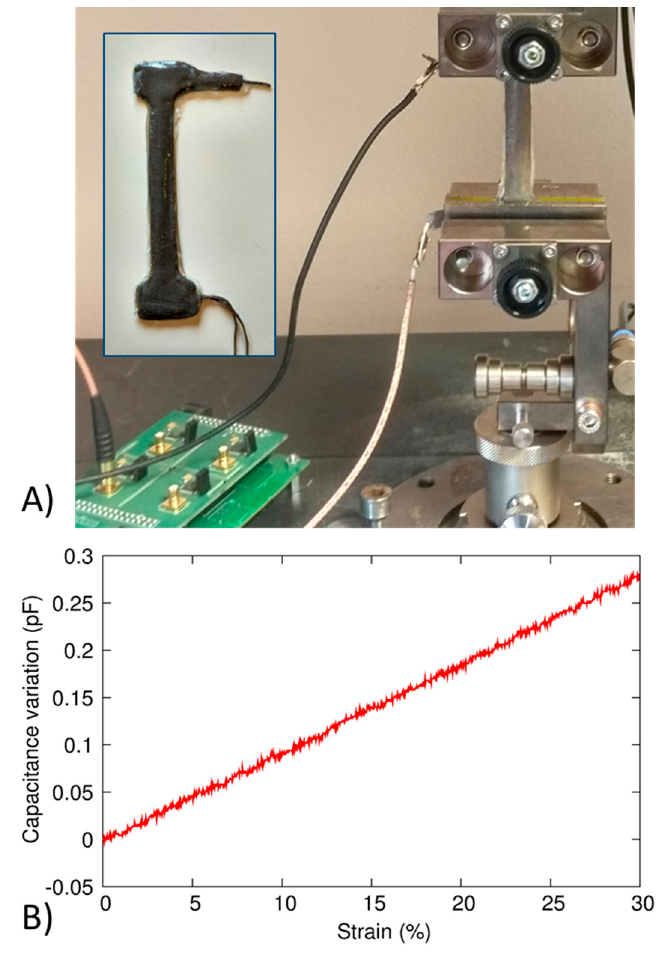
Figure 5. ( A ) Experimental setup for the characterization of the single capacitive strain sensor; ( B ) Capacitive variation vs. strain output characteristic .